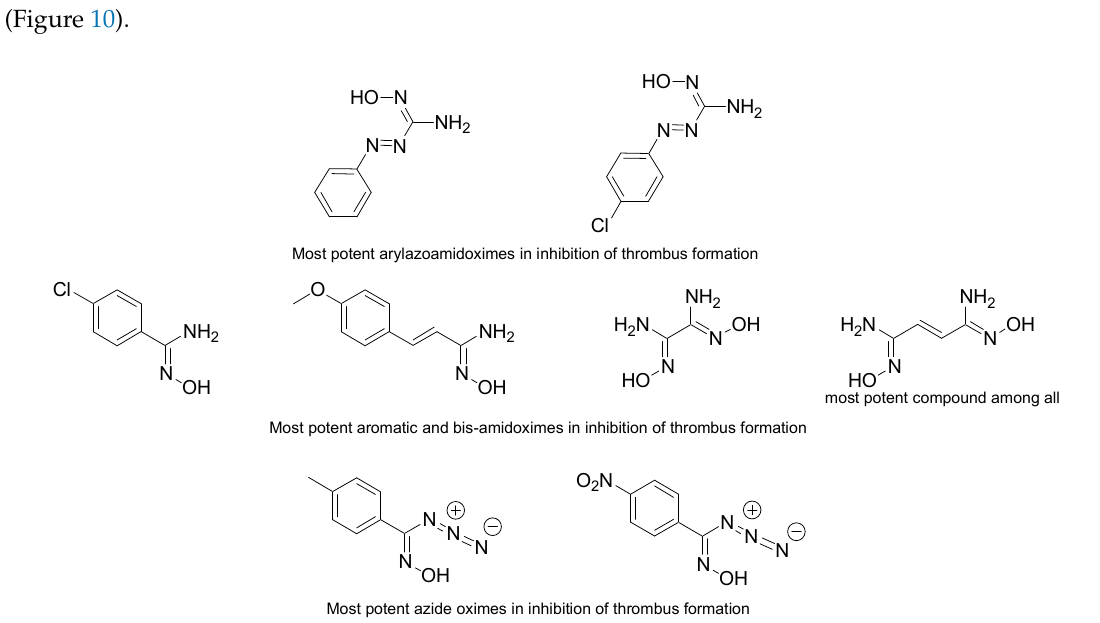
Figure 10. Most potent amidoximes and oximes in the inhibition of thrombus formation according to the studies of Rehse et